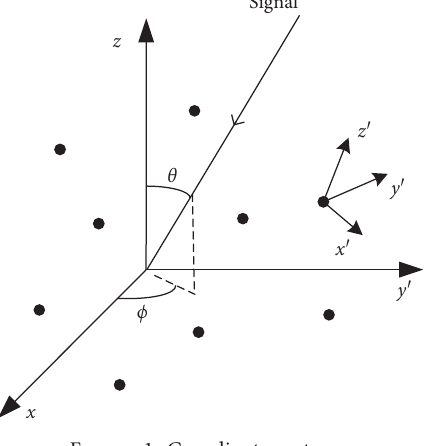
Figure 1: Coordinate